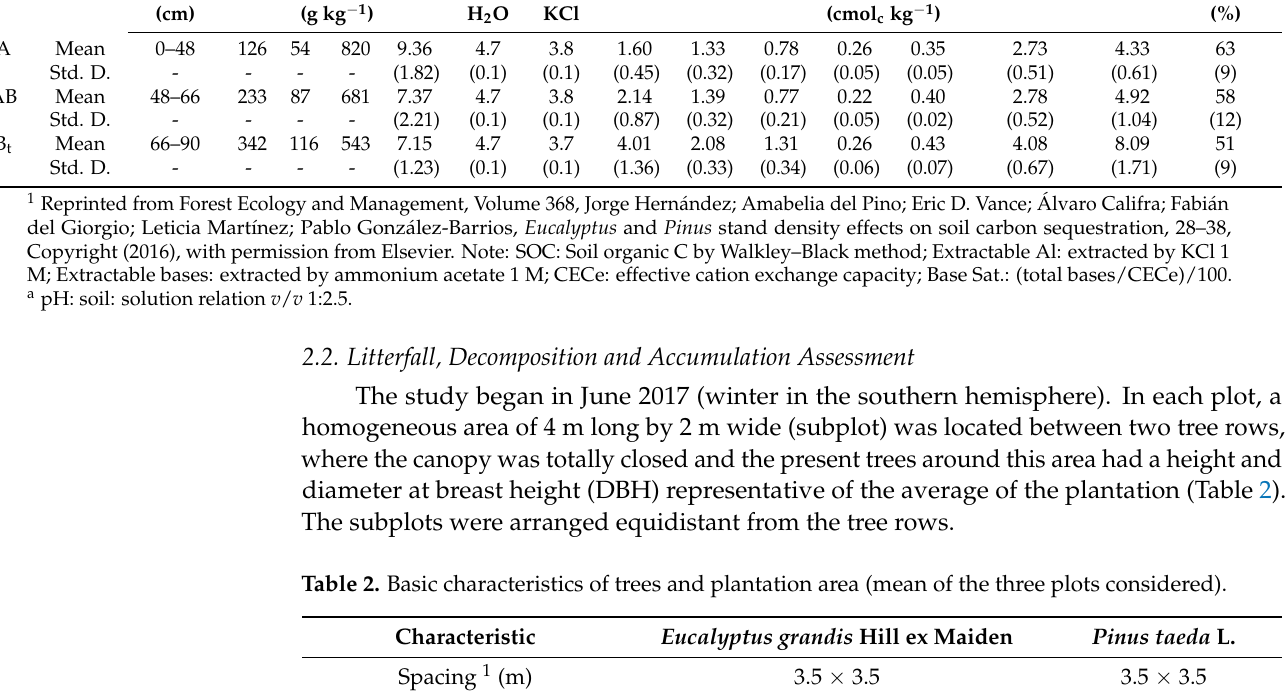
Table 1. Characteristics of A, AB and B horizons from nine soil profiles (mean and standard deviation) 1 . Hor.